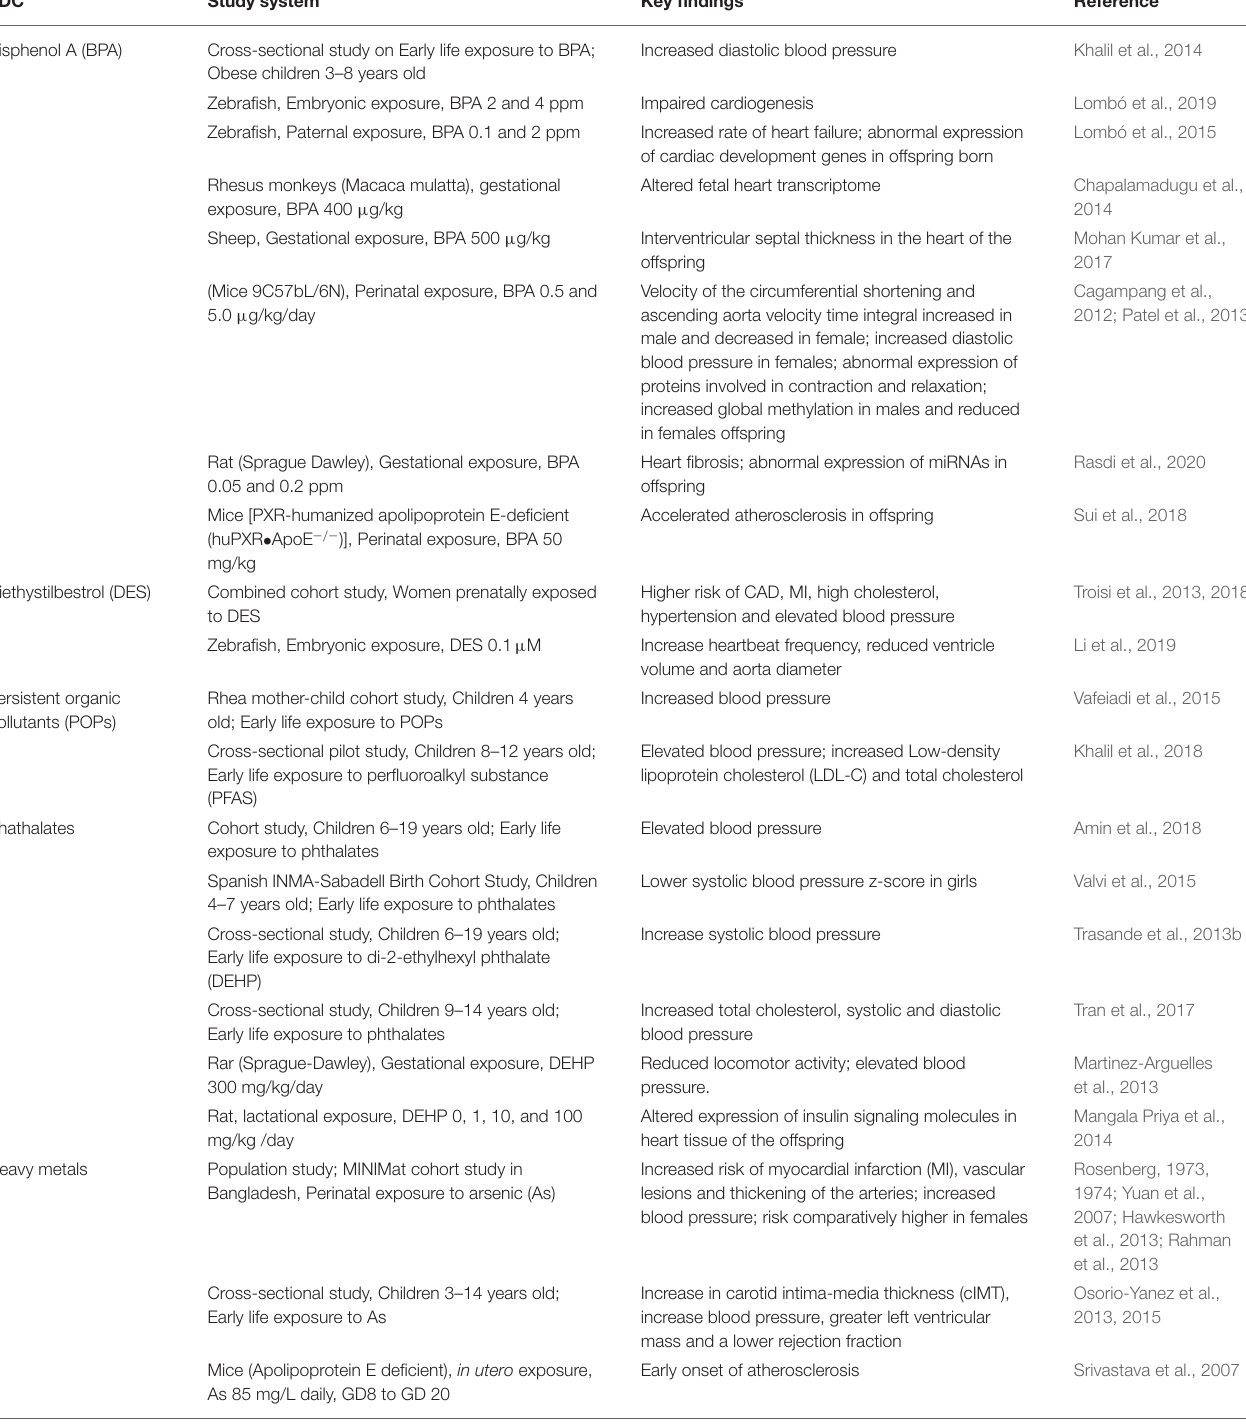
TABLE 4 | EDC exposure and cardiovascular